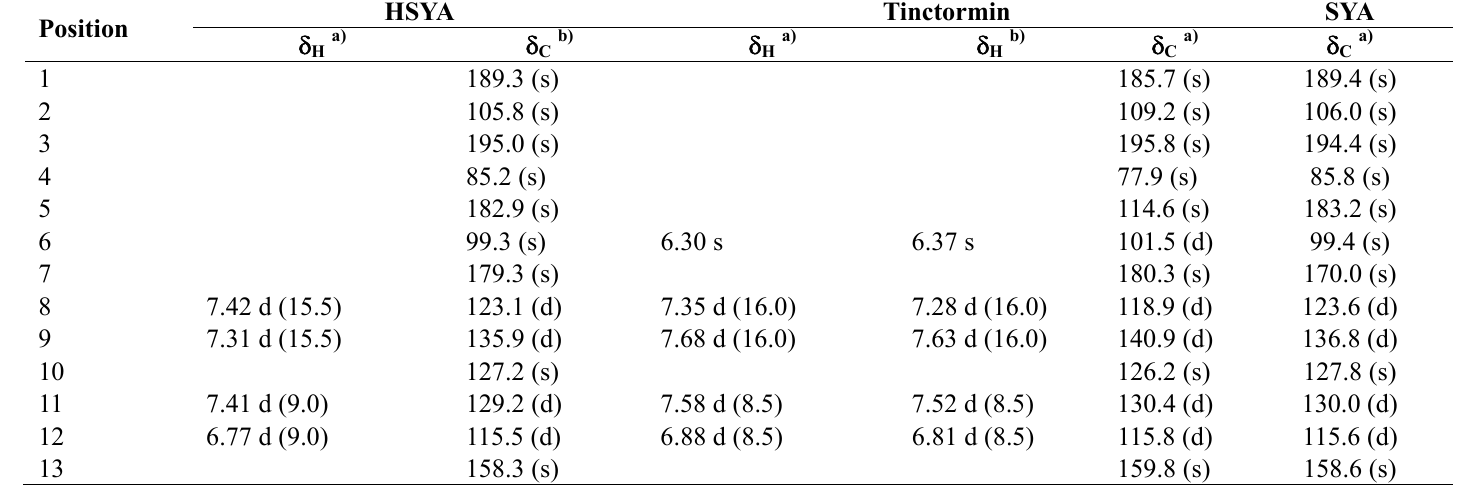
Table 15. NMR data for HSYA, tinctormin, and